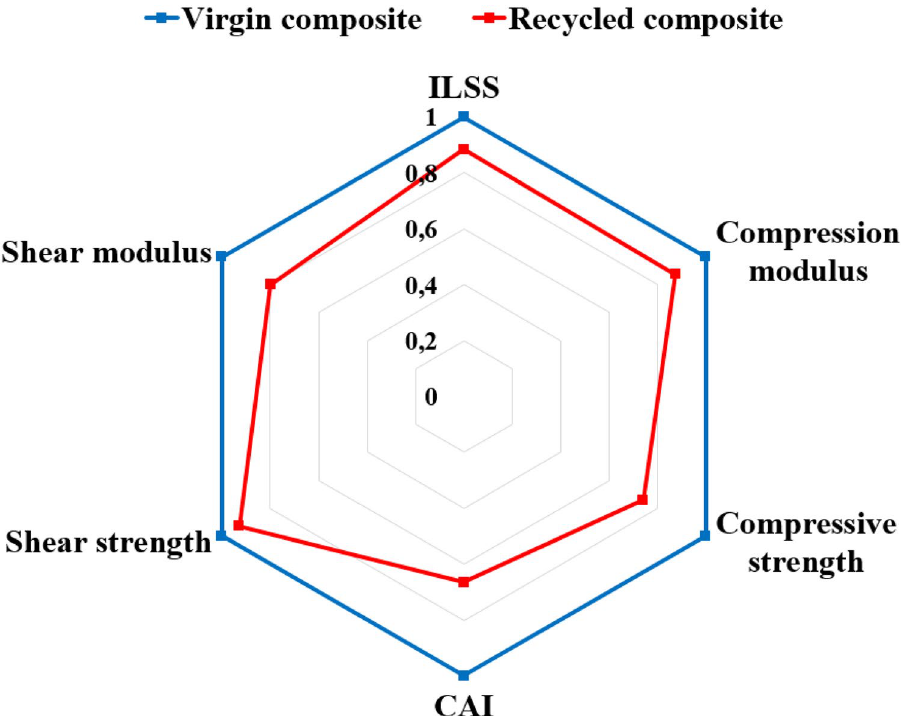
Figure 12. Spider chart summarizing the main mechanical propoerties for virgin and recycled